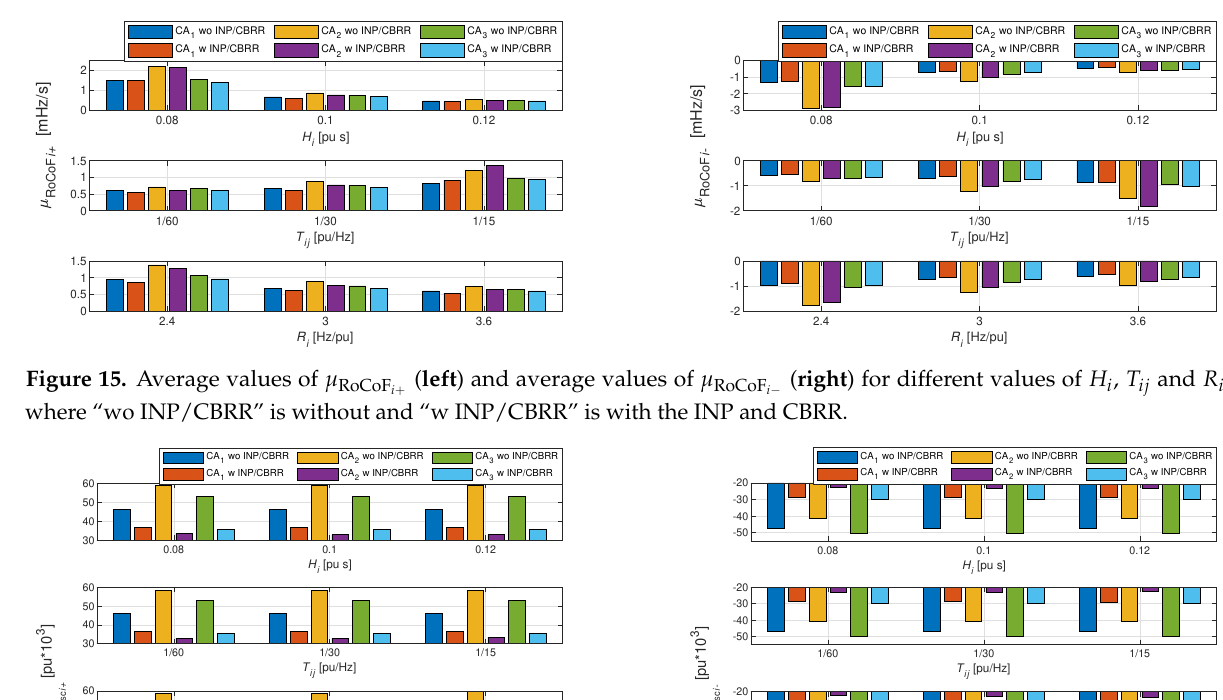
Figure 16. Average values of µ ∆ P “wo INP/CBRR” is without and “w INP/CBRR” is with the INP and